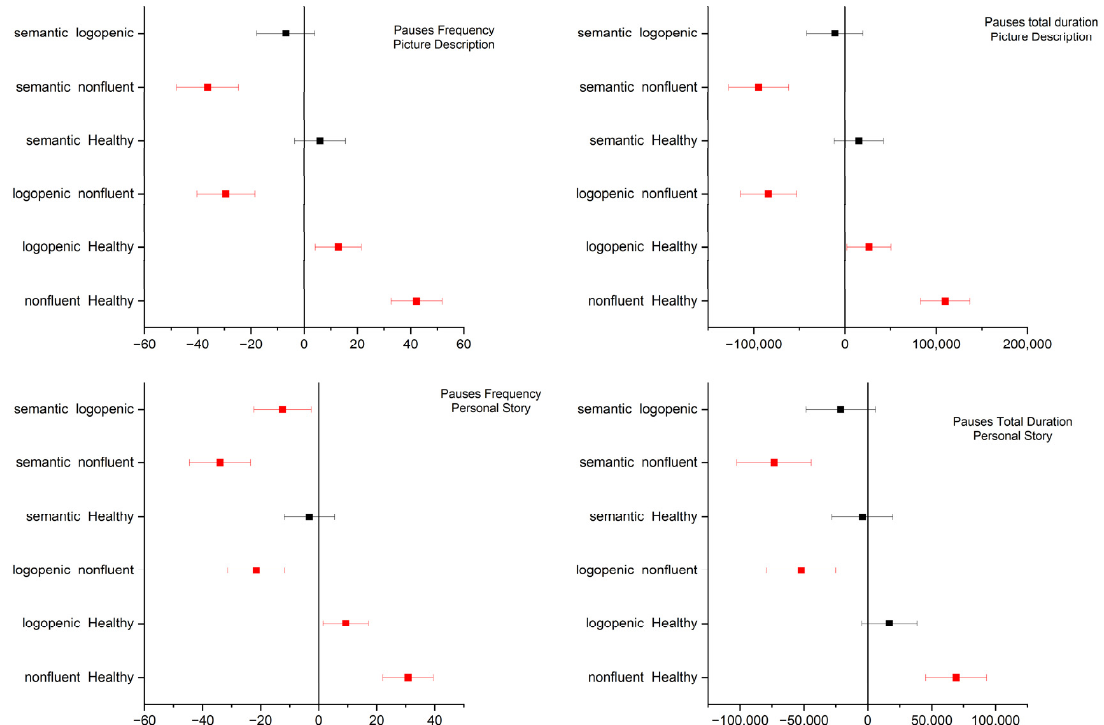
Figure 3. Tukey’s significance test of the one-way ANOVA results for the pause total duration and frequency data of each type of diagnosis. First row: picture description task. Second row: personal story narration. Significance level: 0.05.